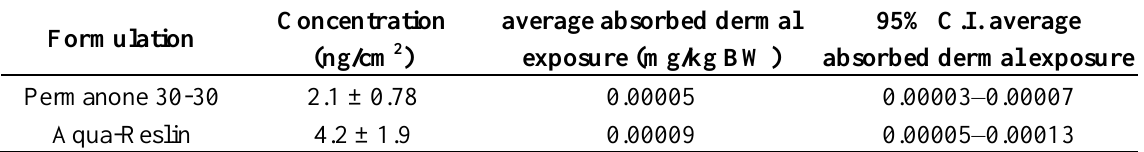
Table 1. Mean permethrin deposition on mannequins in ng/cm 2 ± standard error, estimated average absorbed dermal exposure mg/kg body weight (BW), and the 95% confidence interval (C.I.) (mg/kg BW) estimated average absorbed dermal exposure for Permanone ® 30-30 and Aqua-Reslin ®